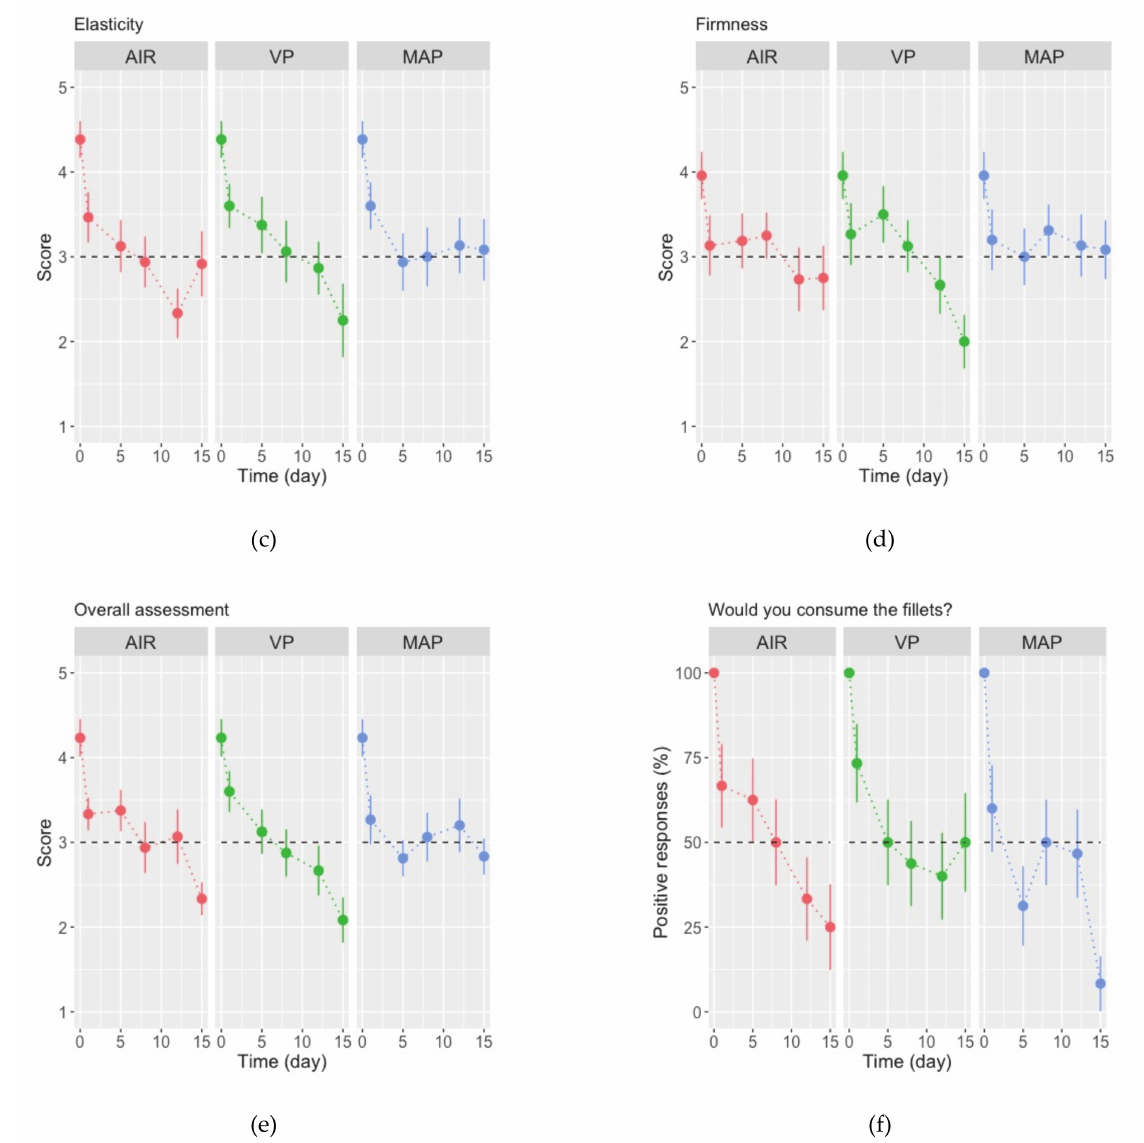
Figure 4. Changes in ( a – e ) sensory parameters and (f) in the intention to consume (%) fillets of triggerfish packed in air (AIR), vacuum (VP), and modified atmosphere (MAP) stored refrigerated for 15 days. Values are means of n = 14–16 panelists’ assessments, and whiskers represent the standard-error (SE). Horizontal dashed lines represent an intermediate score in the 1–5 scale in ( a – e ) and the 50% positive responses in